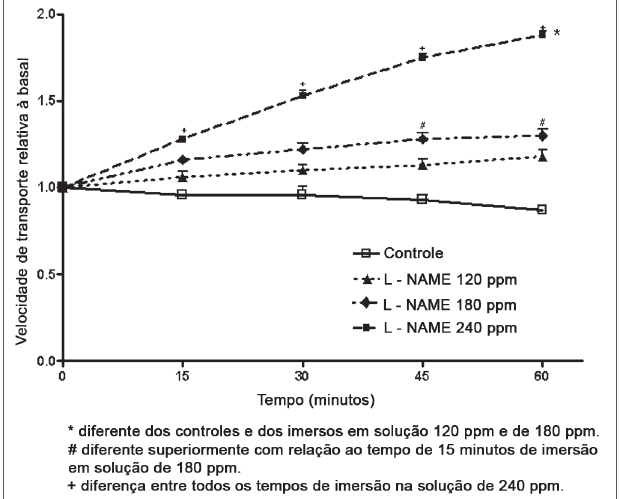
Figura 2. Velocidade relativa de transporte mucociliar em palatos de rã imersos em solução deRinger R (controles) ou em soluções de